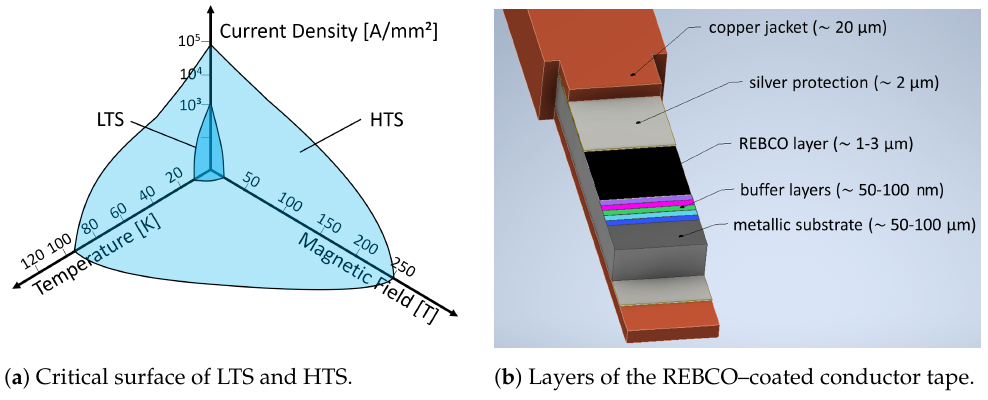
Figure 1. ( a ) Comparison of the critical surface phase space for LTS and HTS formed by the three interdependent characteristic parameters of a superconductor, i.e., the critical temperature, critical magnetic field, and critical current density. Superconductivity can only occur below the critical surfaces, which are unique for each material. The figure is inspired by [8]. ( b ) Structure of a complex– layered REBCO HTS–coated conductor tape. Note the substrate and buffer layers residing under the REBCO coating, the silver and copper stabilizing, and protecting